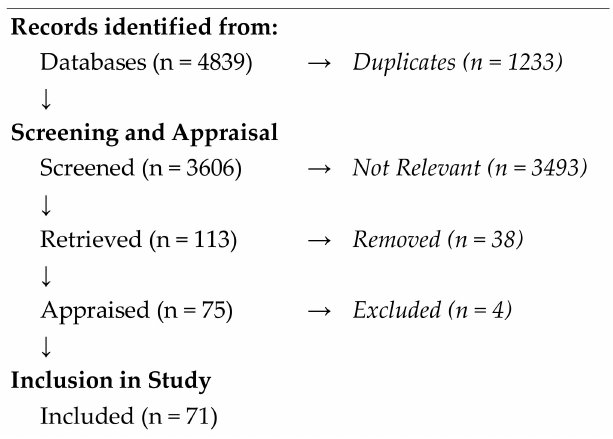
Figure 1. PRISMA diagram for